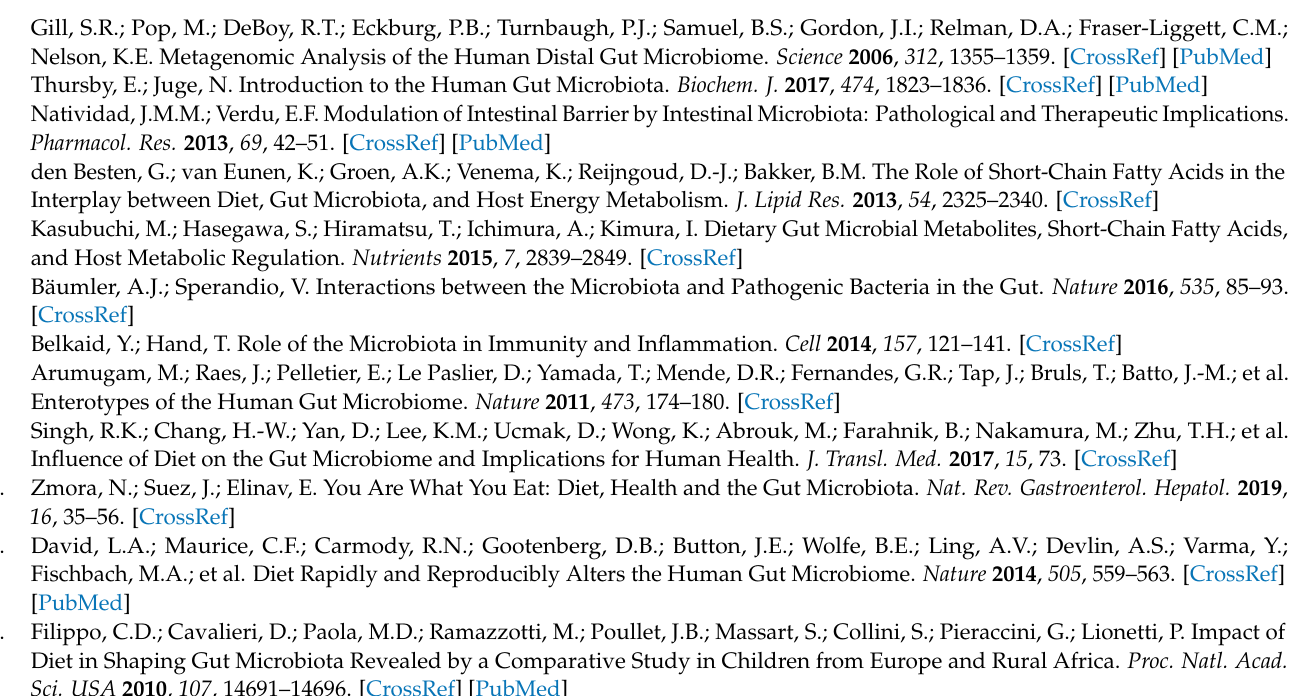
Figure S1: Plots to select optimal numbers of clusters with Elbow, Silhouette, and Gap statistic methods on k-means clustering for identifying enterotypes based on unweighted and weighted UniFrac, and Bray-Curtis distance matrices; Figure S2: Enterotypes of gut microbiota in